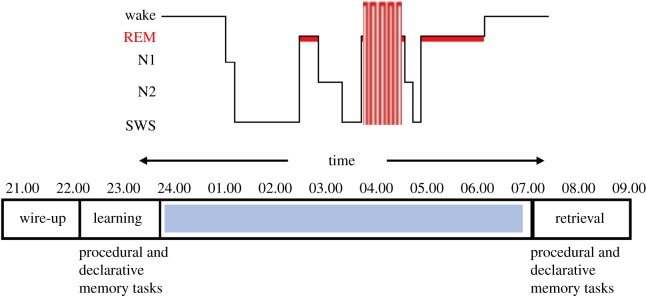
Depiction of experimental protocol. W, wake; REM, rapid eye-movement sleep; N1, N2: stages of non-rapid eye-movement sleep (NREM); SWS, slow-wave sleep.